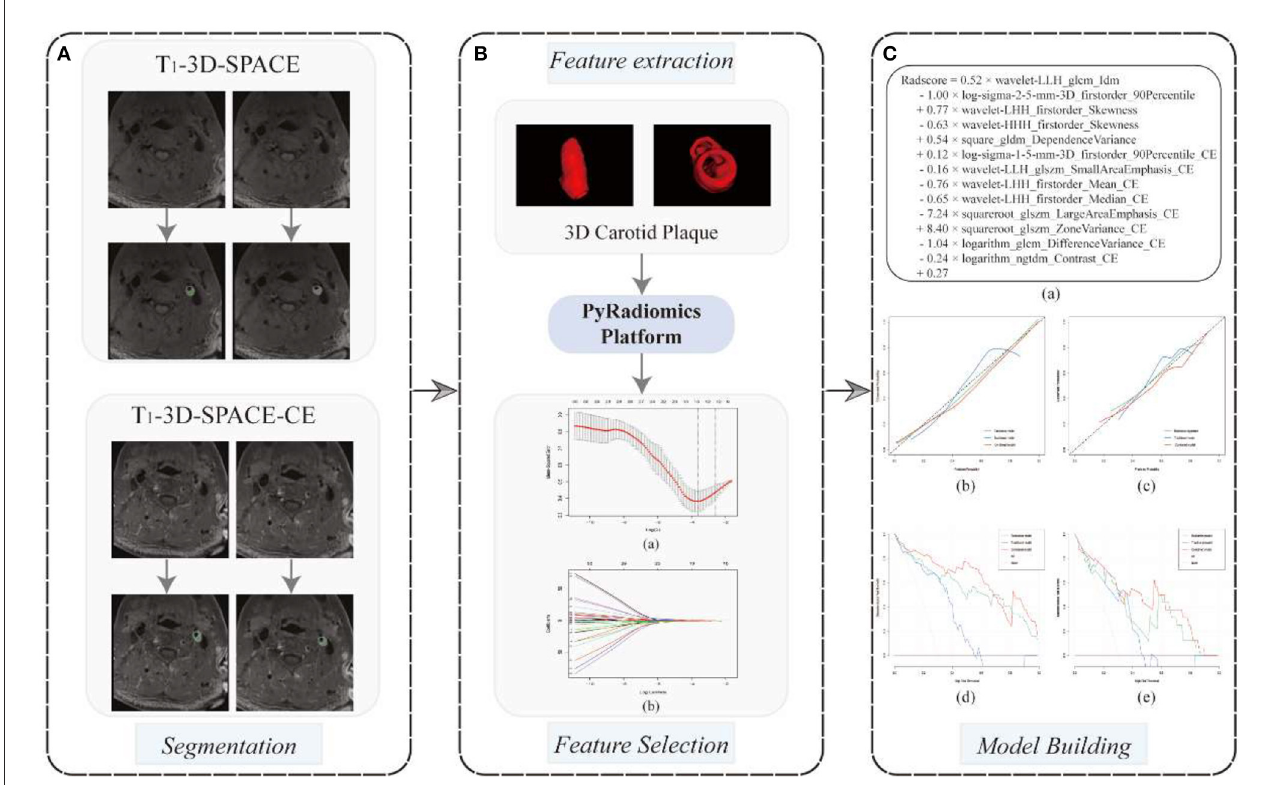
FIGURE1 A flowchart of radiomics model development. (A) 3D carotid plaque segmentation in 3D T 1 -SPACE and 3D T 1 -SPACE- CE sequences, respectively; (B) PyRadiomics-based radiomics feature extraction, 13radiomics features were screened at the minimum mean square error of the LASSO regression and used to build radiomics models (a, b); (C) The formulation of radiomics signature (a); The calibration curves (b, c) and decision curves analysis (d, e) for the training and testing cohorts were employed to evaluate the traditional model, the radiomics model and the combined model, respectively.